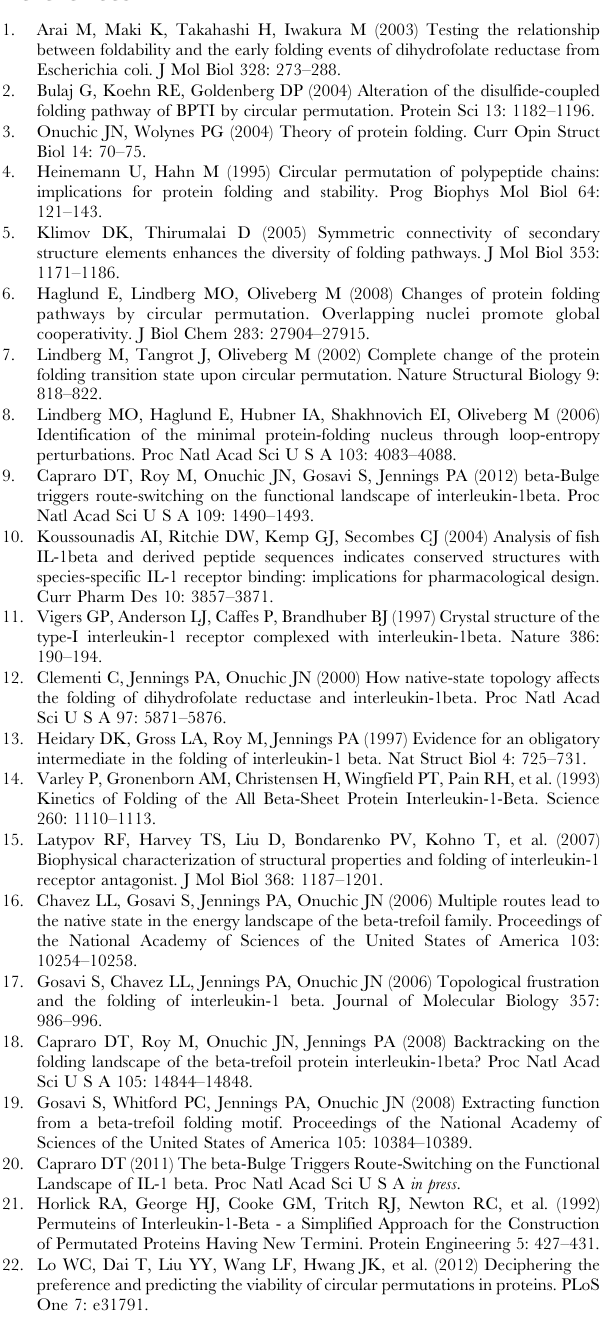
Table S1 Protection factors for WT IL-1 b and permu- tant variants. Table S2 Backbone amides identified in pulse labeling experiment and their secondary structure